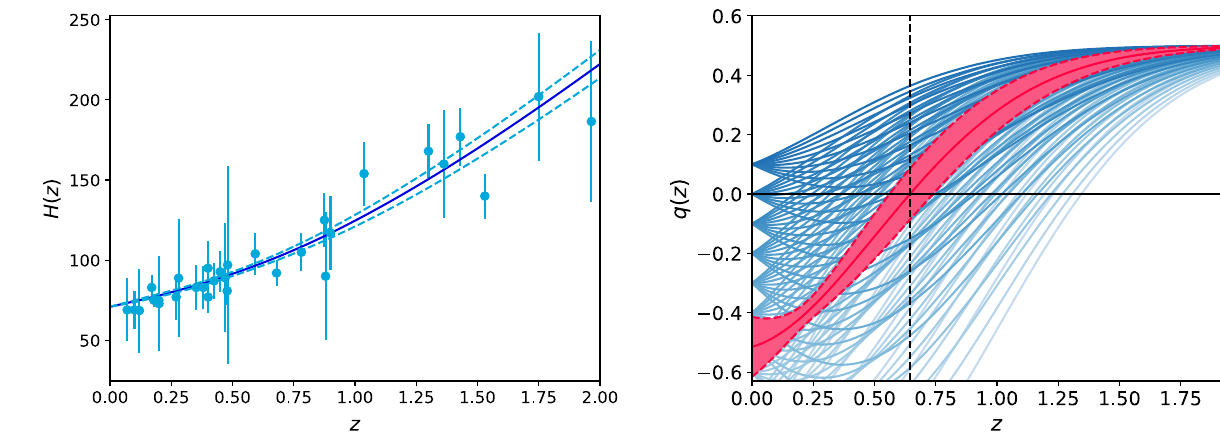
MCMC analysis. The black dashed line in the right panel represents the transitional redshift, z t , for the joint analysis mean value